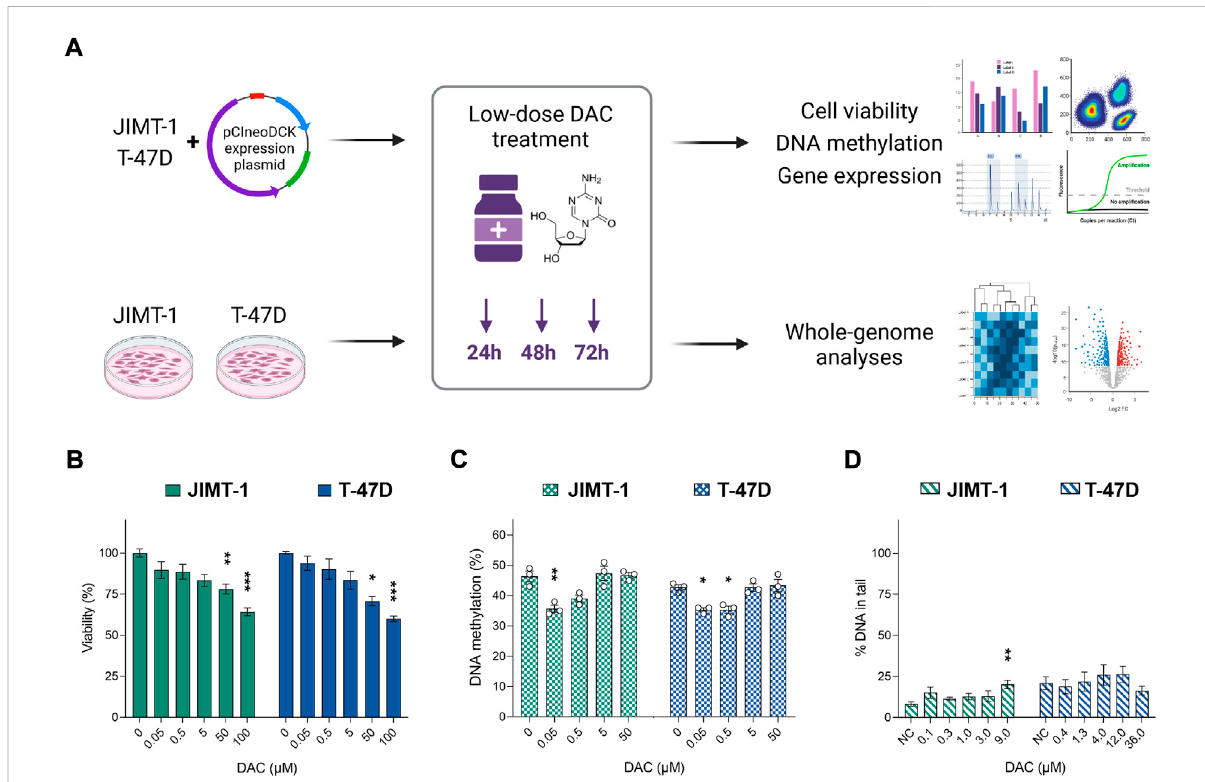
FIGURE 1 Theimpactofincreasingdecitabine(DAC)concentrationsoncellviability,DNAmethylation,andDNAdamage. (A) Experimentaldesign; (B) Cell viability changes induced by exposure to increasing DAC concentrations added every 24 h for a total of 72 h. Relative cell viability values were evaluated by luminescent viability assay and expressed as mean ± SEM. Differences to untreated cells; * p < 0.05, ** p < 0.01, *** p < 0.001; (C) Exposure-induced changes in global DNA methylation levels; (D) Impact of DAC exposure on DNA damage, measured as strand breaks by comet